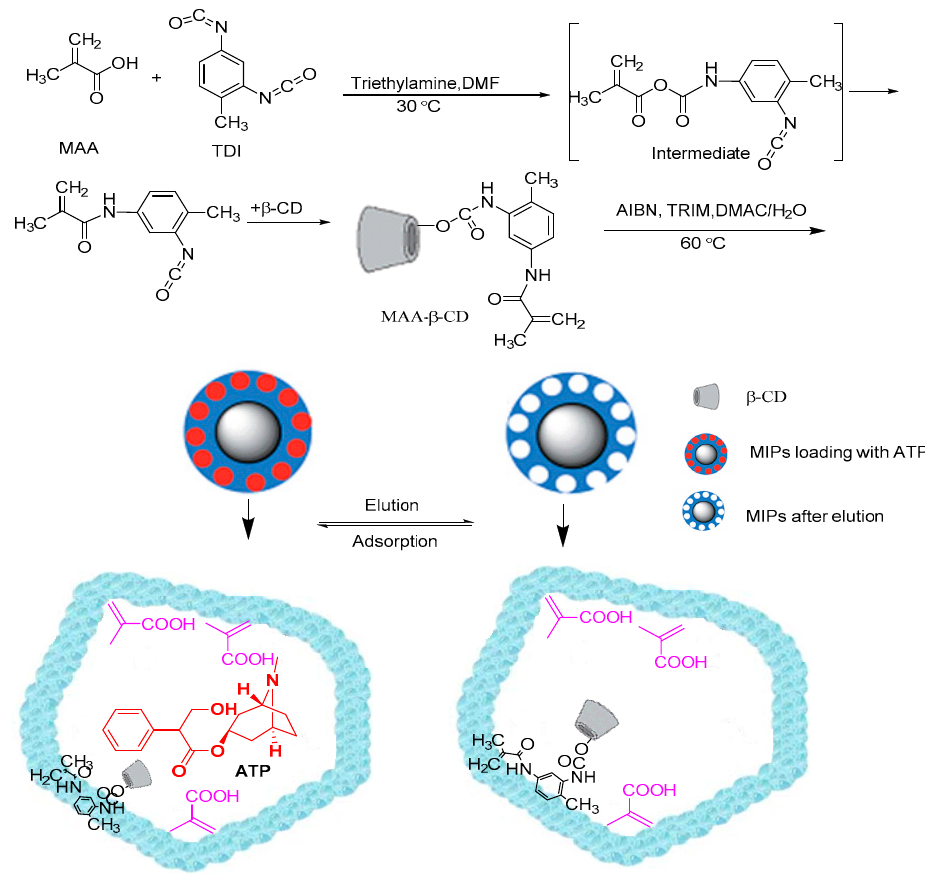
Figure 1. A scheme for preparation of ATP molecularly imprinted polymers (MIPs).